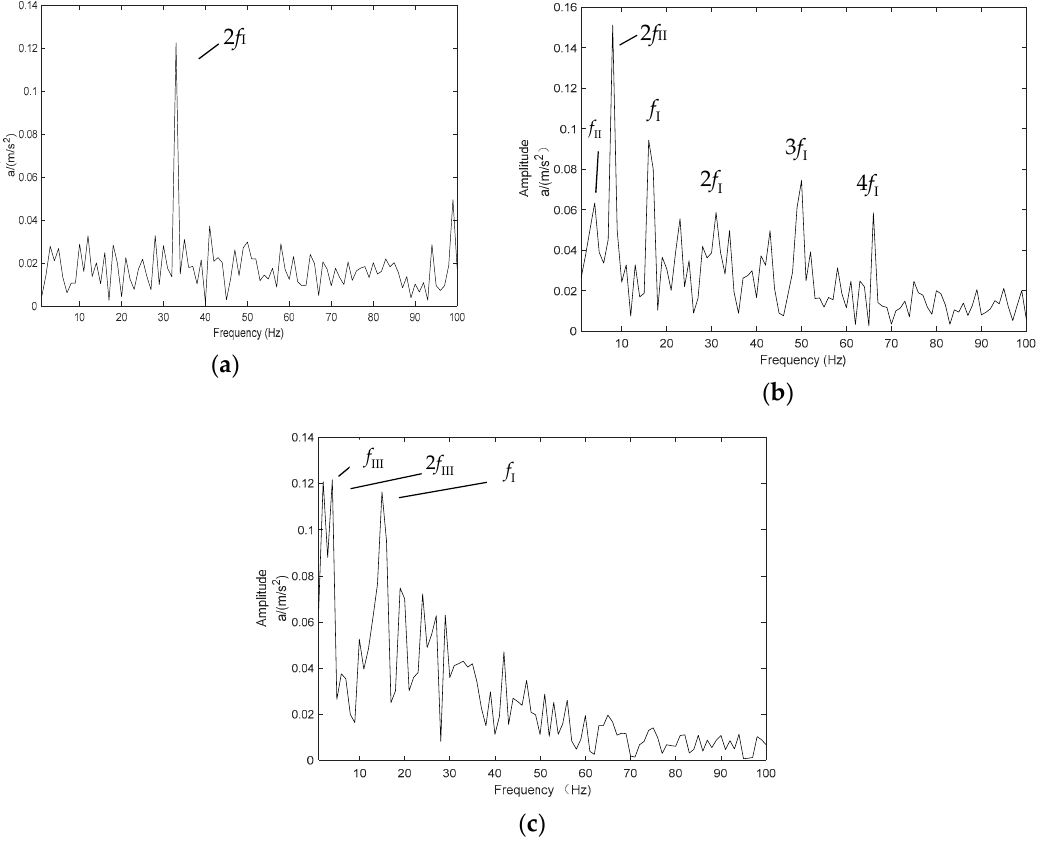
Figure 20. The Hilbert envelope spectrum of the MOC components: ( a ) Hilbert envelope spectrum of MOC 1 ( t ); ( b ) Hilbert envelope spectrum of MOC 2 ( t ); ( c ) Hilbert envelope spectrum of MOC 3 ( t